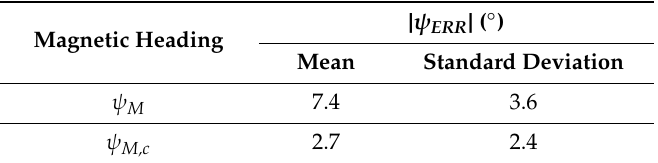
Table 2. Time statistics of the absolute value of the magnetic heading estimation error. Calibrated vs. non-calibrated case. The symbol | · | indicates the absolute value